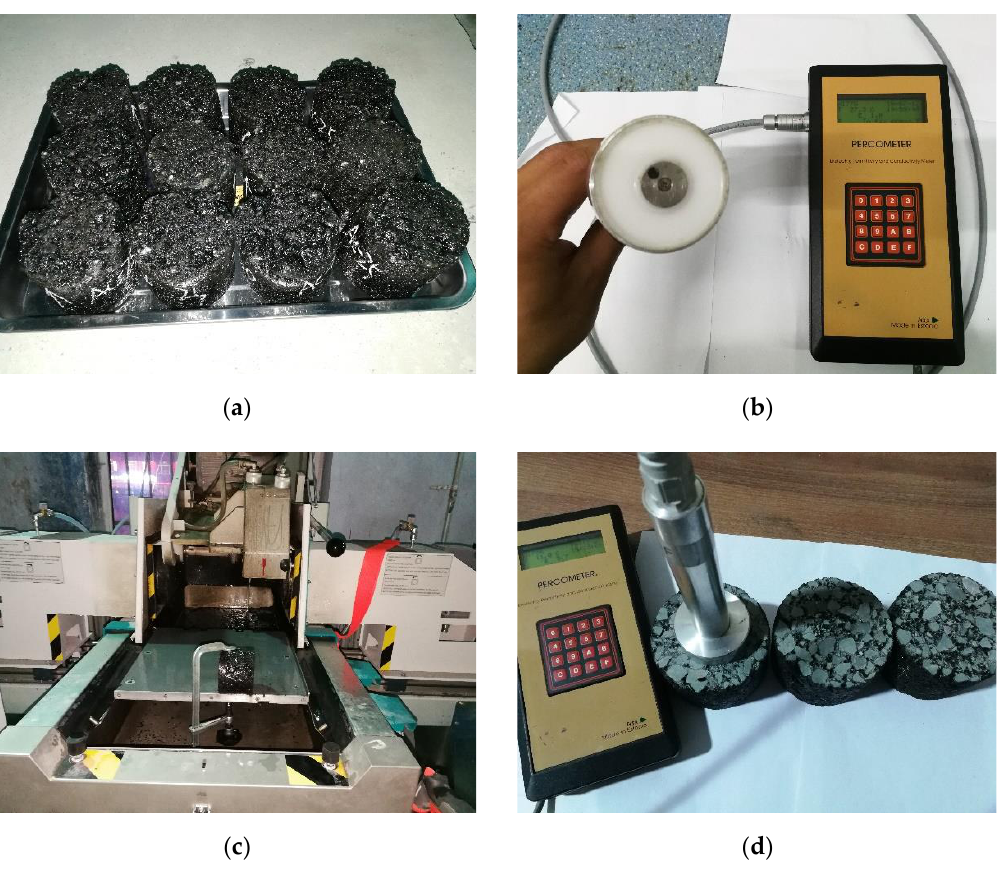
Figure 4. Measurement of dielectric constant of test piece. ( a ) Rotating compacted specimen. ( b ) Percometer instrument. ( c ) Specimen cutting. ( d ) Dielectric constant measurement of test piece.